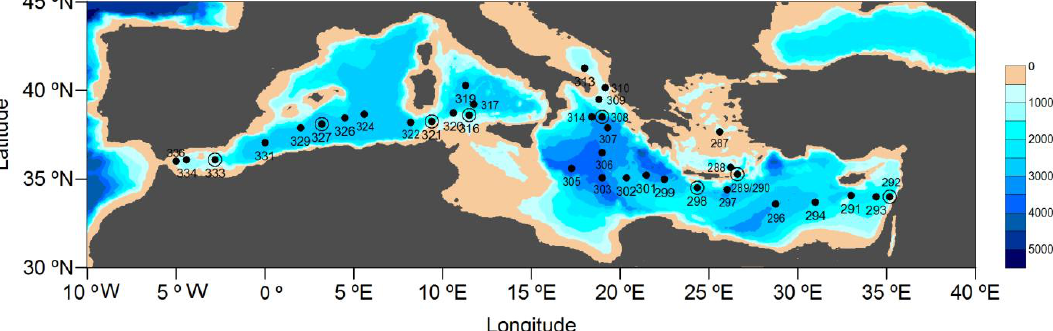
Fig. 1. Location of sampling stations. Map of the study area in the Mediterranean Sea showing the stations where prokaryotic abundance and/or the bacterial community composition was determined (see Table S1 in the Supplement). The stations indicated by encircled dots were subjected to the finer vertical scale sampling to investigate bacterial community structure down the water column. The figure was generated by SURFER 11- Golden Software.